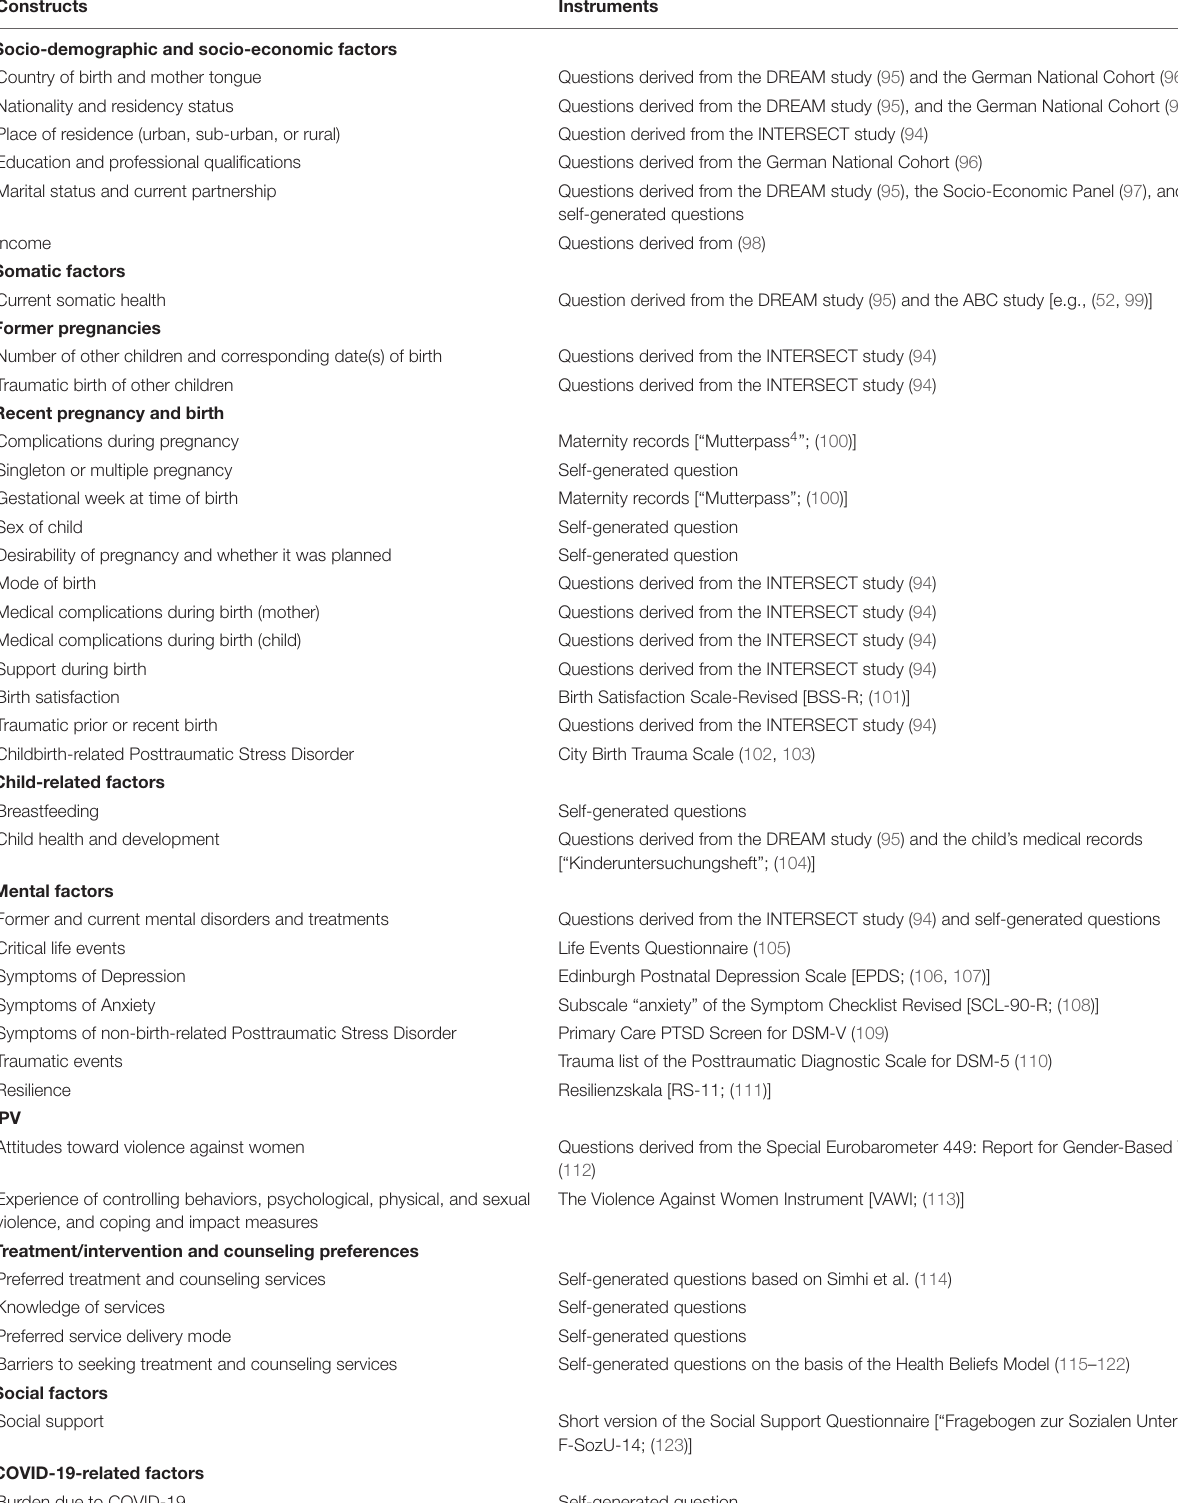
TABLE 1 | Constructs and instruments in the INVITE